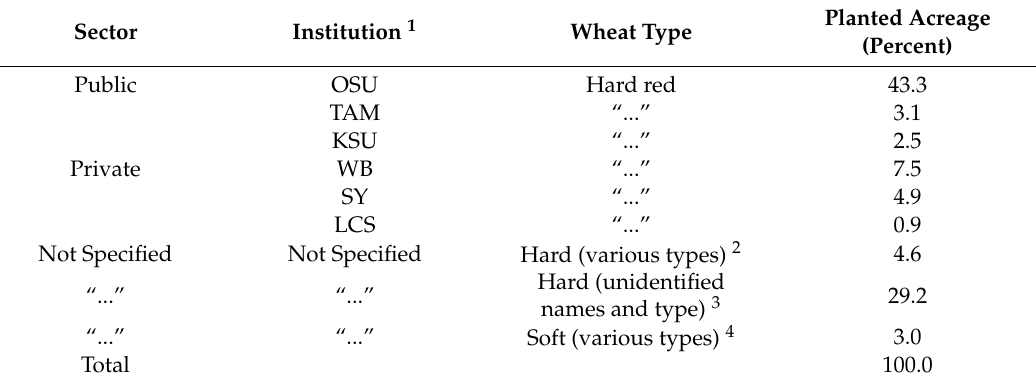
Table 1. Oklahoma hard red wheat variety Planted by Institution: 2019 production